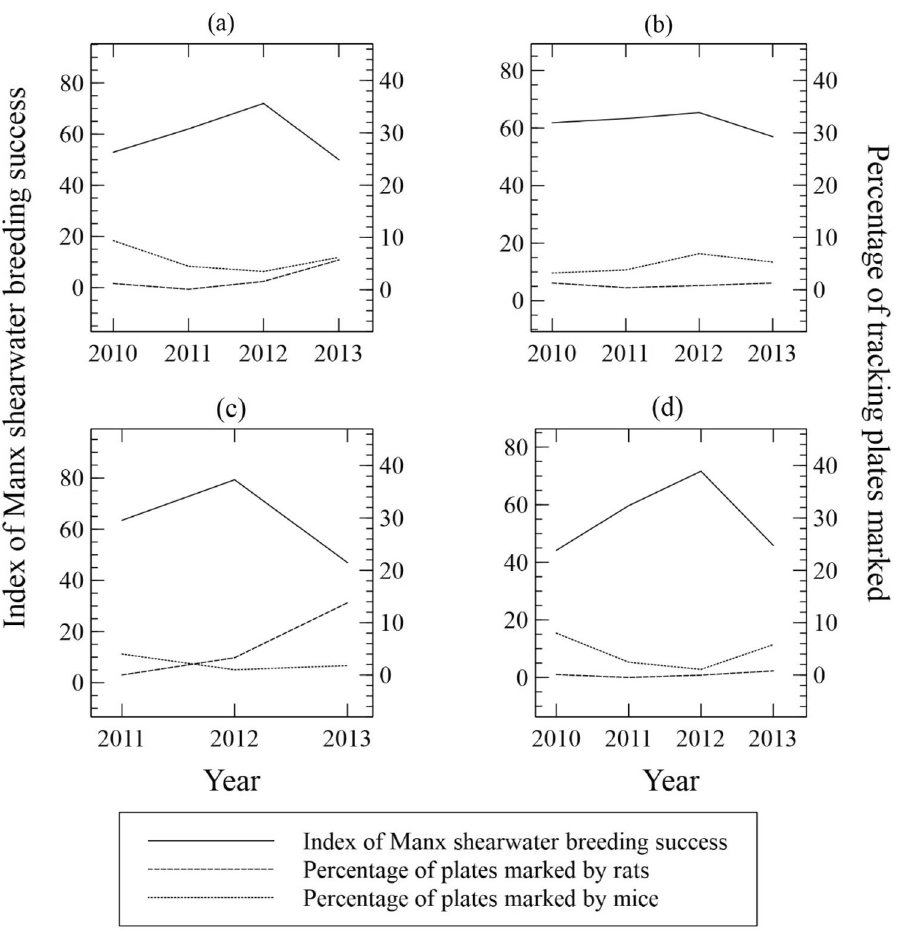
Figure 2. Relationship between percentage of tracking plates marked by Norway rats or wood mice and breeding success of Manx shearwaters (percentage of burrows containing a live chick in late summer) at three study sites on the Island of Rum 2010–2013. Data are shown for the three study sites combined ( a ), and individually for each site Askival ( b ), Clough’s Crag ( c ) and Hallival ( d ).